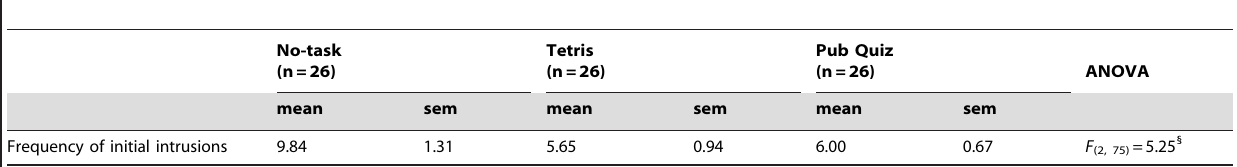
Table 8. Experiment 2 frequency of initial intrusions during the 10-min experimental manipulation [i.e. during computer game play or no-task condition].